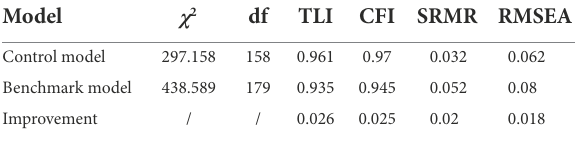
TABLE 1 Characteristics of the research sample ( N = 226). TABLE 2 Common method bias